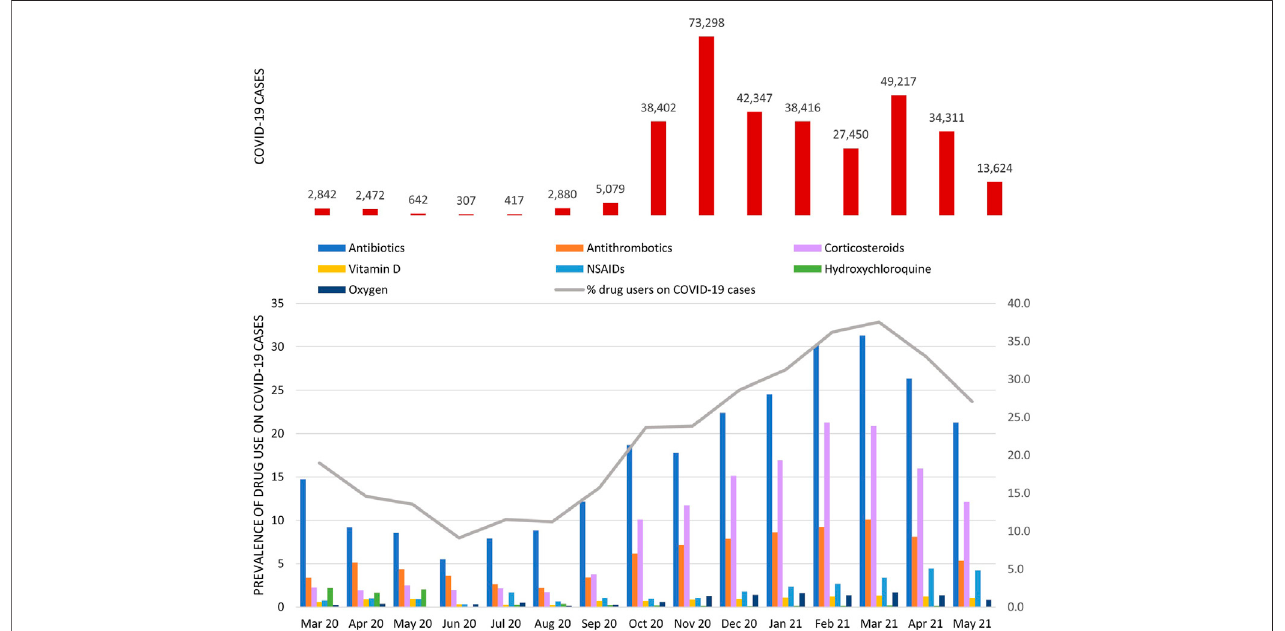
FIGURE 2 | COVID-19 cases and prevalence of study drug use among COVID-19 cases strati fi ed by calendar month. The gray line represents the monthly percentage of COVID-19 cases with at least one study drug in the exposure window (from 3 days before to 7 days post-COVID-19); bars show the monthly prevalence of use of speci fi c drug